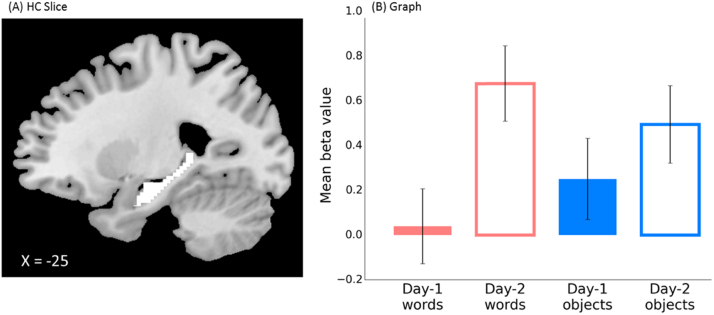
(A) Location of a bilateral hippocampus ROI defined using the AAL template brain. (B) This region showed differential activation (graphed as the contrast of activation versus an unmodelled resting baseline) for novel words and objects learned on days 1 and 2, collapsed across see-think and see-speak conditions and left/right hippocampus. Red= words, blue= objects, solid bars= day 1 items, empty bars= day 2 items.